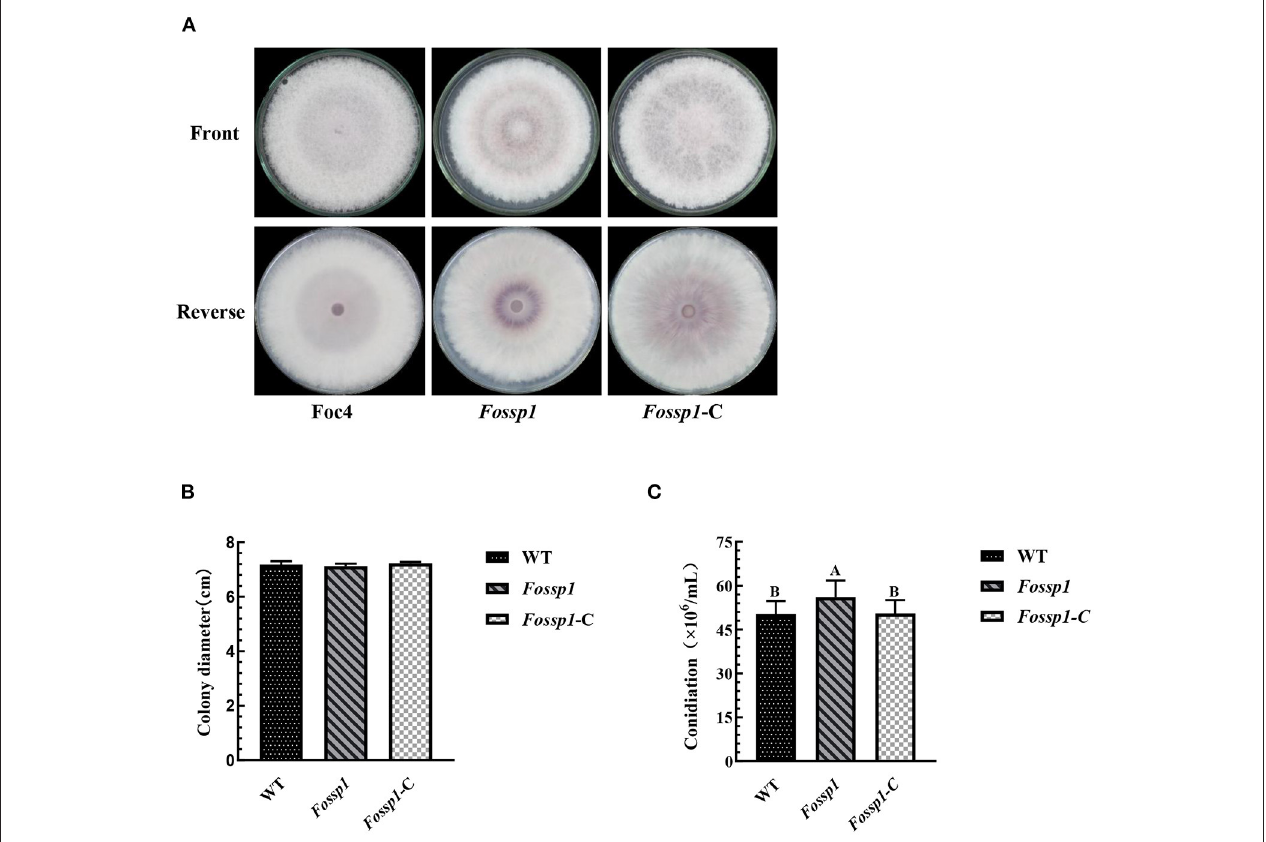
FIGURE 4 | Effects of Fossp1 deletion on colony morphology, growth rate, and spore yield of Foc4. (A,B) Colony morphology and growth rate of WT, Fossp1, and Fossp1 -C cultures on PDA medium for 6 days. (C) Conidiation of WT, Fossp1, and Fossp1 -C cultures in PDB medium for 2 days. The results are representative of three independent experiments. The error bars represent the standard error. Identical and conserved catalytic residues are marked with